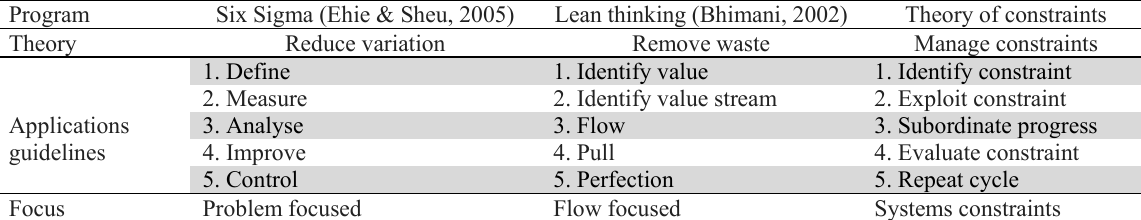
The focus of various methods for improvement (Nave,